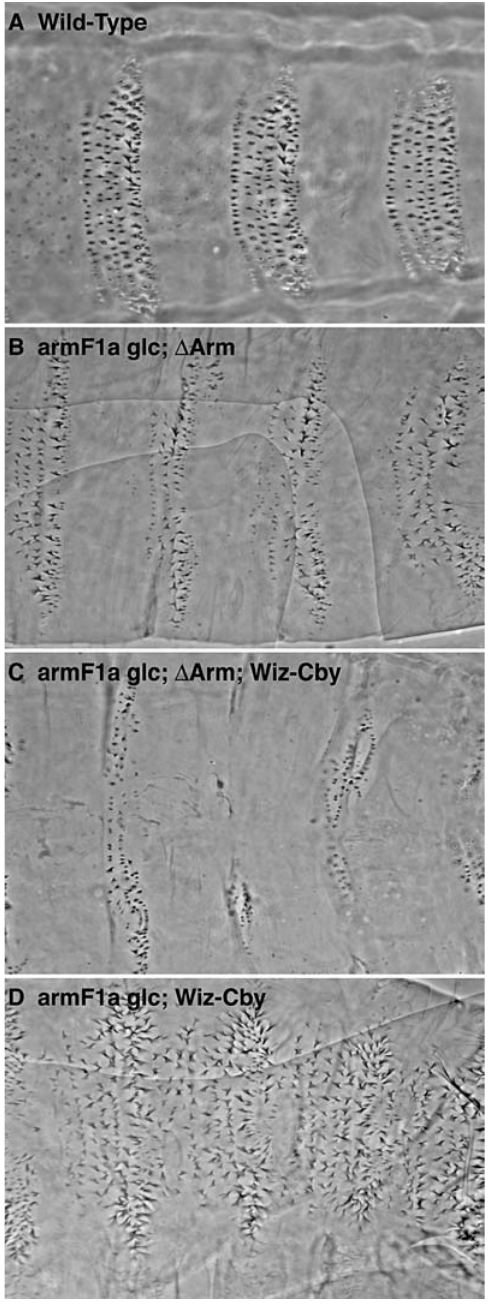
Figure 6. Relief of C-Terminal Repression through the Elimination of Cby Leads to Uniform Activation of Signaling (A) A wild-type cuticle shown for comparison. (B) Expression of Arm D Arm in the arm F1a background. (C) Expression of a Cby RNAi construct along with Arm D Arm in the arm F1a background. (D) Expression of a Cby RNAi construct in an arm F1a background. DOI: 10.1371/journal.pbio.0020095.g006